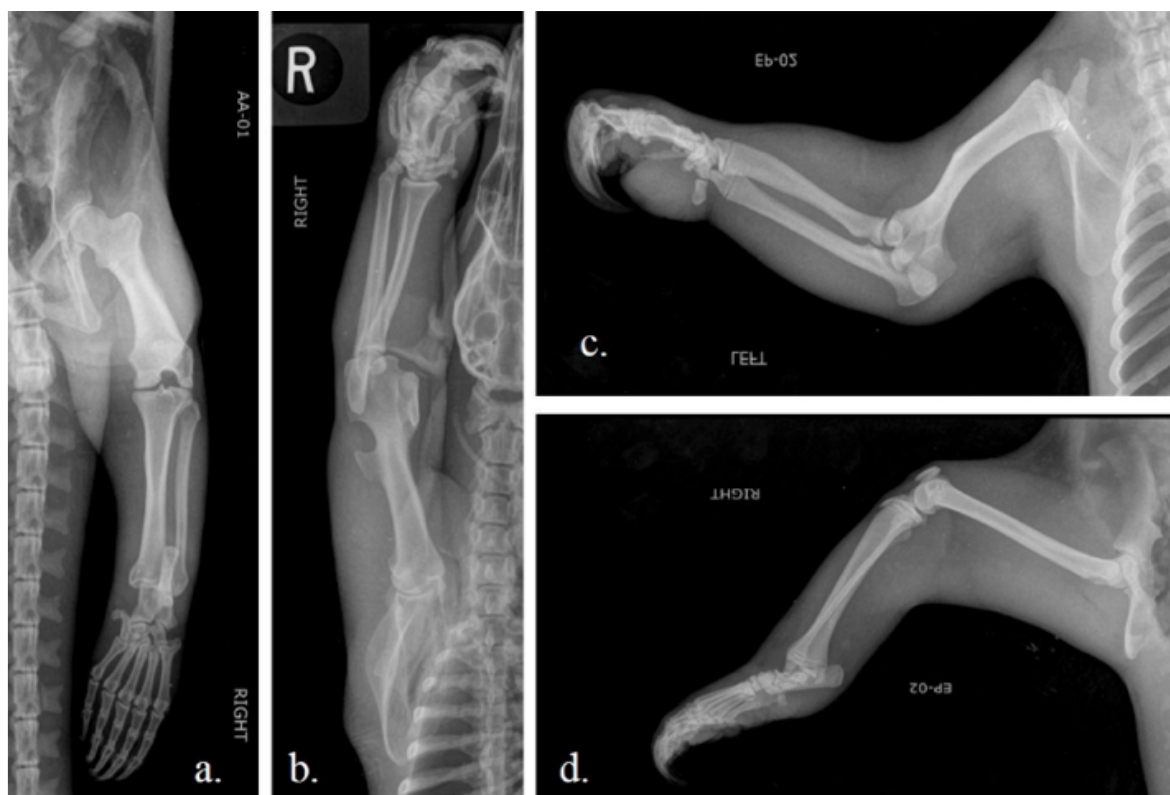
2. Four X-rays of complete T. mexicana normal extremities. Anteroposterior (AP) and lateral projections (L) are represented. a — AP projection of the pelvic limb | b — AP projection of the thoracic limb | c — L projection of the thoracic limb | d — L projection of the pelvic